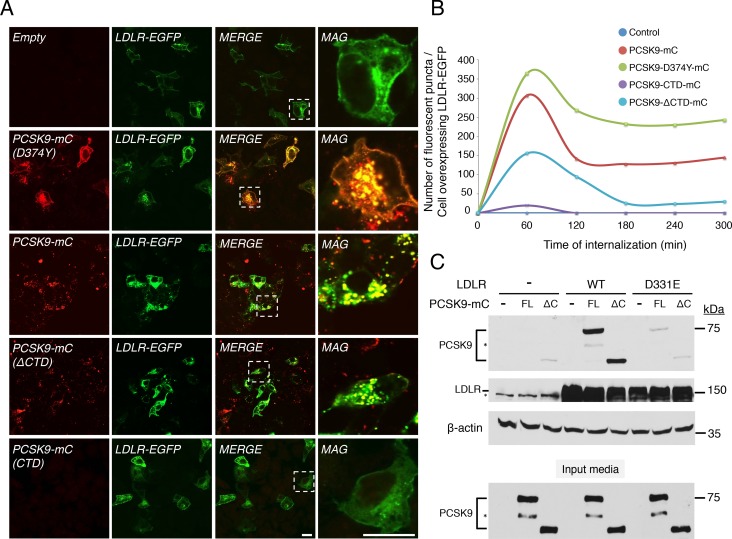
PCSK9 CTD is required for efficient LDLR-mediated endocytosis of PCSK9.(A) HepG2 cells transfected with LDLR-EGFP were incubated 5h with conditioned media obtained from HEK293 cells transected without (Empty) or with PCSK9 WT-, D374Y-, ΔCTD- or CTD-mC. PCSK9-mC constructs and LDLR-EGFP were analyzed by live-cell confocal microscopy. Selected regions (dashed squares) were digitally zoomed 5X (MAG). Scale bars = 20 μM. (B) Quantification of the number of intracellular red fluorescent puncta per cell expressing LDLR-EGFP for each PCSK9 mCherry fusion construct described in (A) after incubation for 0, 60, 120, 180, 240 and 300 min. PCSK9 WT-mC (n = 37 cells), D374Y-mC (n = 62 cells), ΔCTD-mC (n = 31 cells) or CTD-mC (n = 52 cells). (C) HEK293 cells were transfected without (-) or with WT LDLR or its EGF-A D331E mutant and incubated for 6 h with DMEM alone (-) or with normalized conditioned media obtained from FL or ΔCTD PCSK9-mC transfected cells (input media). Cell-associated PCSK9-mC, LDLR and β-actin (loading control) protein levels were analyzed by IB. Data are representative of at least three independent experiments.